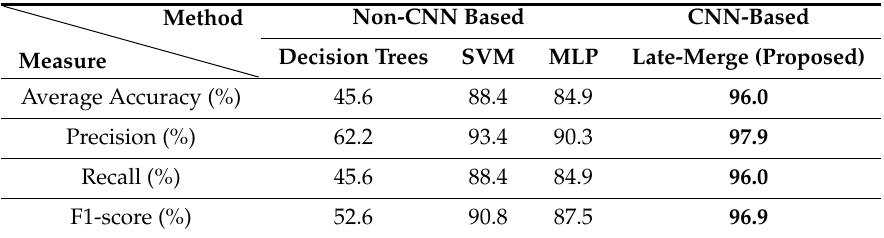
Table 5. Performance of classification by machine-learning